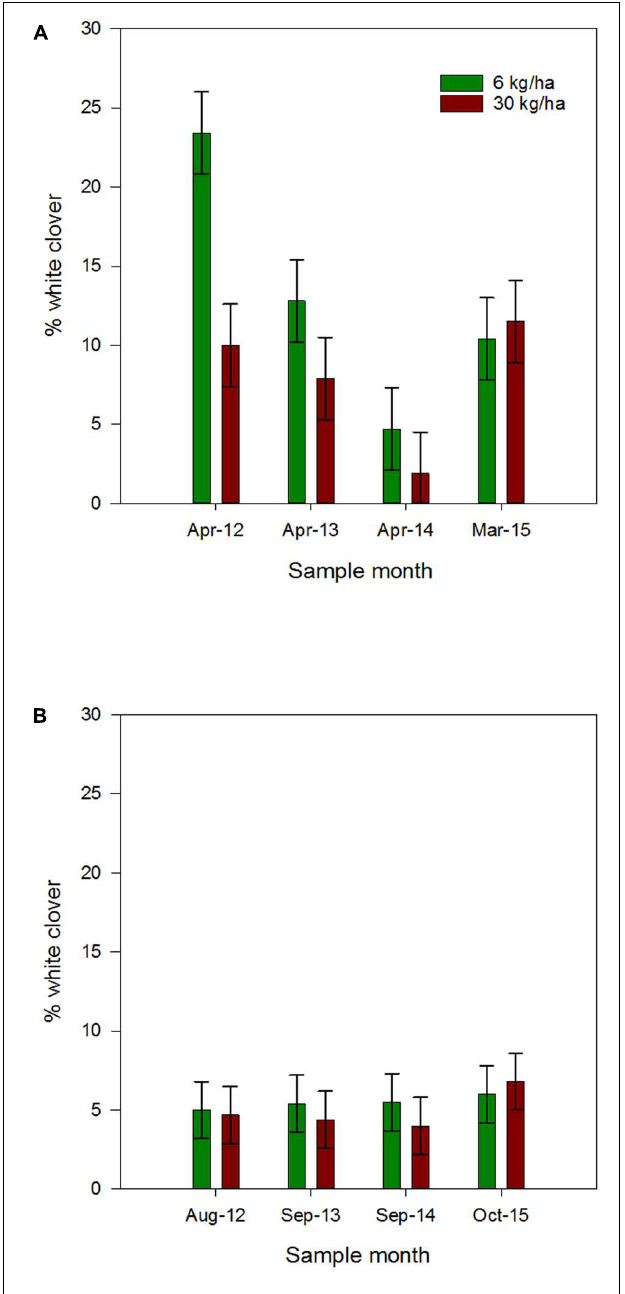
FIGURE 2 | Mean autumn (A) and spring (B) % white clover ( ± SEM) measured in plots containing ryegrass sown at 6 or 30 kg/ha and white clover sown at 8 kg/ha. Autumn values indicated in (B) for